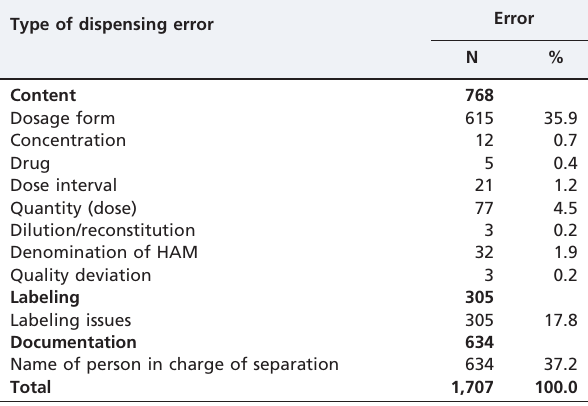
Table 2 - The prevalence of dispensing error types and